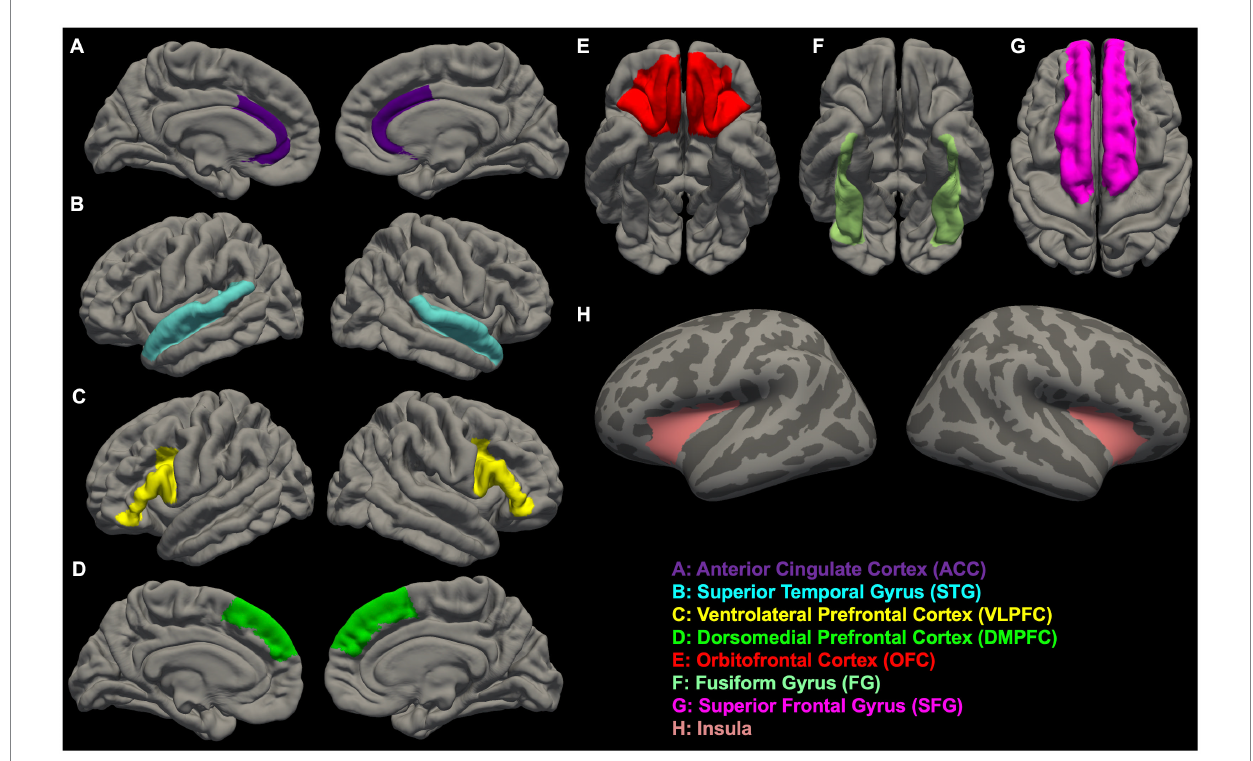
FIGURE 1 Overview of brain regions (A–H) that are most commonly found to be involved in functional MRI and brain morphometry research of suicidal thoughts and behavior.